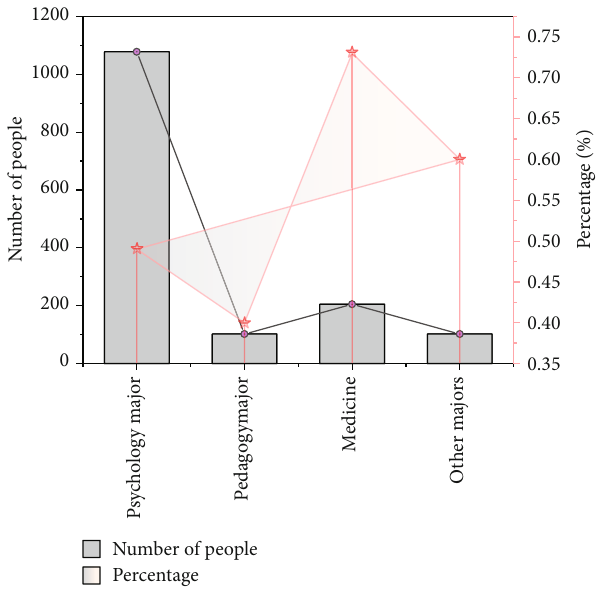
Figure 4: Professional background needs of students expected mental health